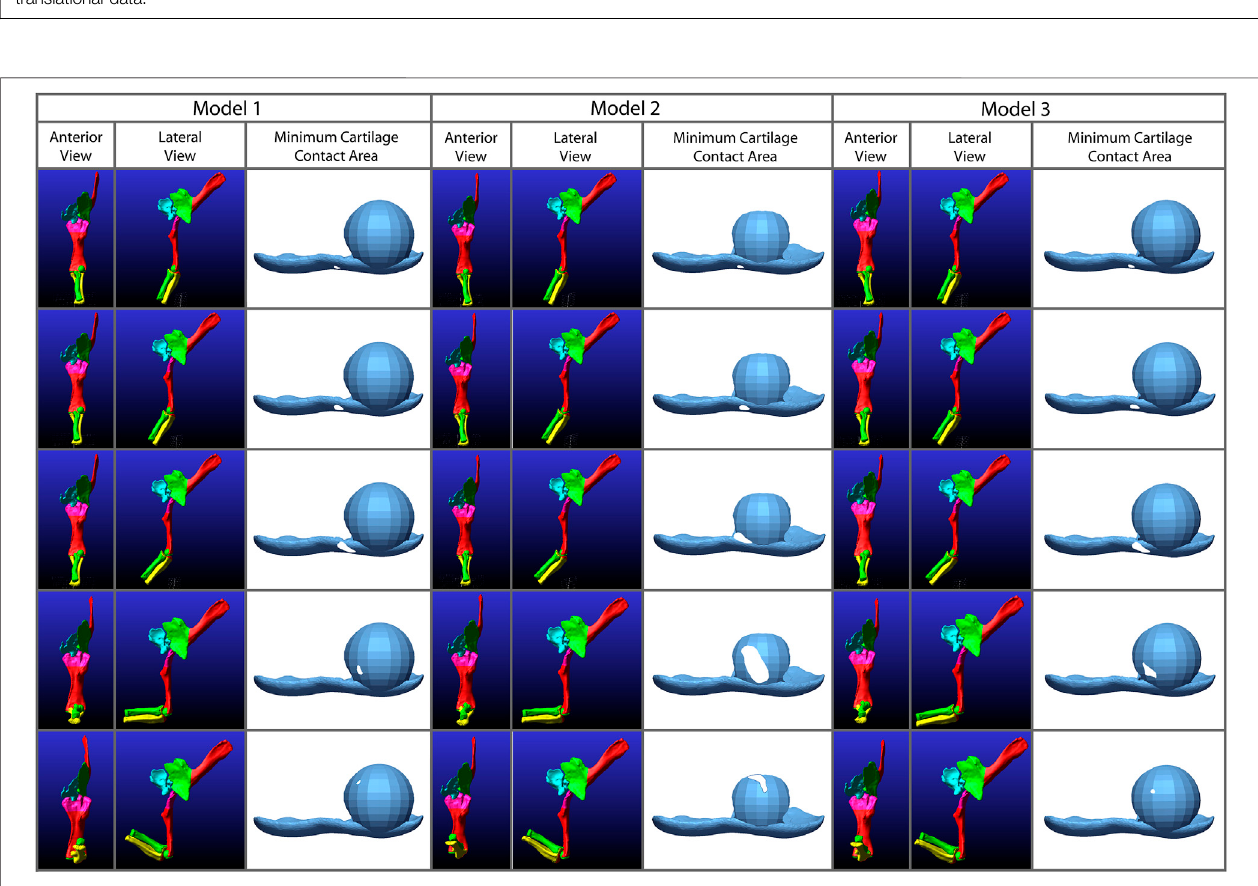
FIGURE 8 | Comparison of the minimum areas of contact (between the radial cartilage and combined 2% thickness and spherical cartilages of the humerus) generated from the simulations of our three Dreadnoughtus models in anterior view. Five time points from each simulation are shown that correspond to increasing degreesof fl exion.Minimumareaofcontactisalwaysrepresentedbywhiteshapes.Model2hasthelargestareaofminimalcontactandmodel1hasthesmallest.Model two also contacts the cartilage sphere the earliest during fl exion.